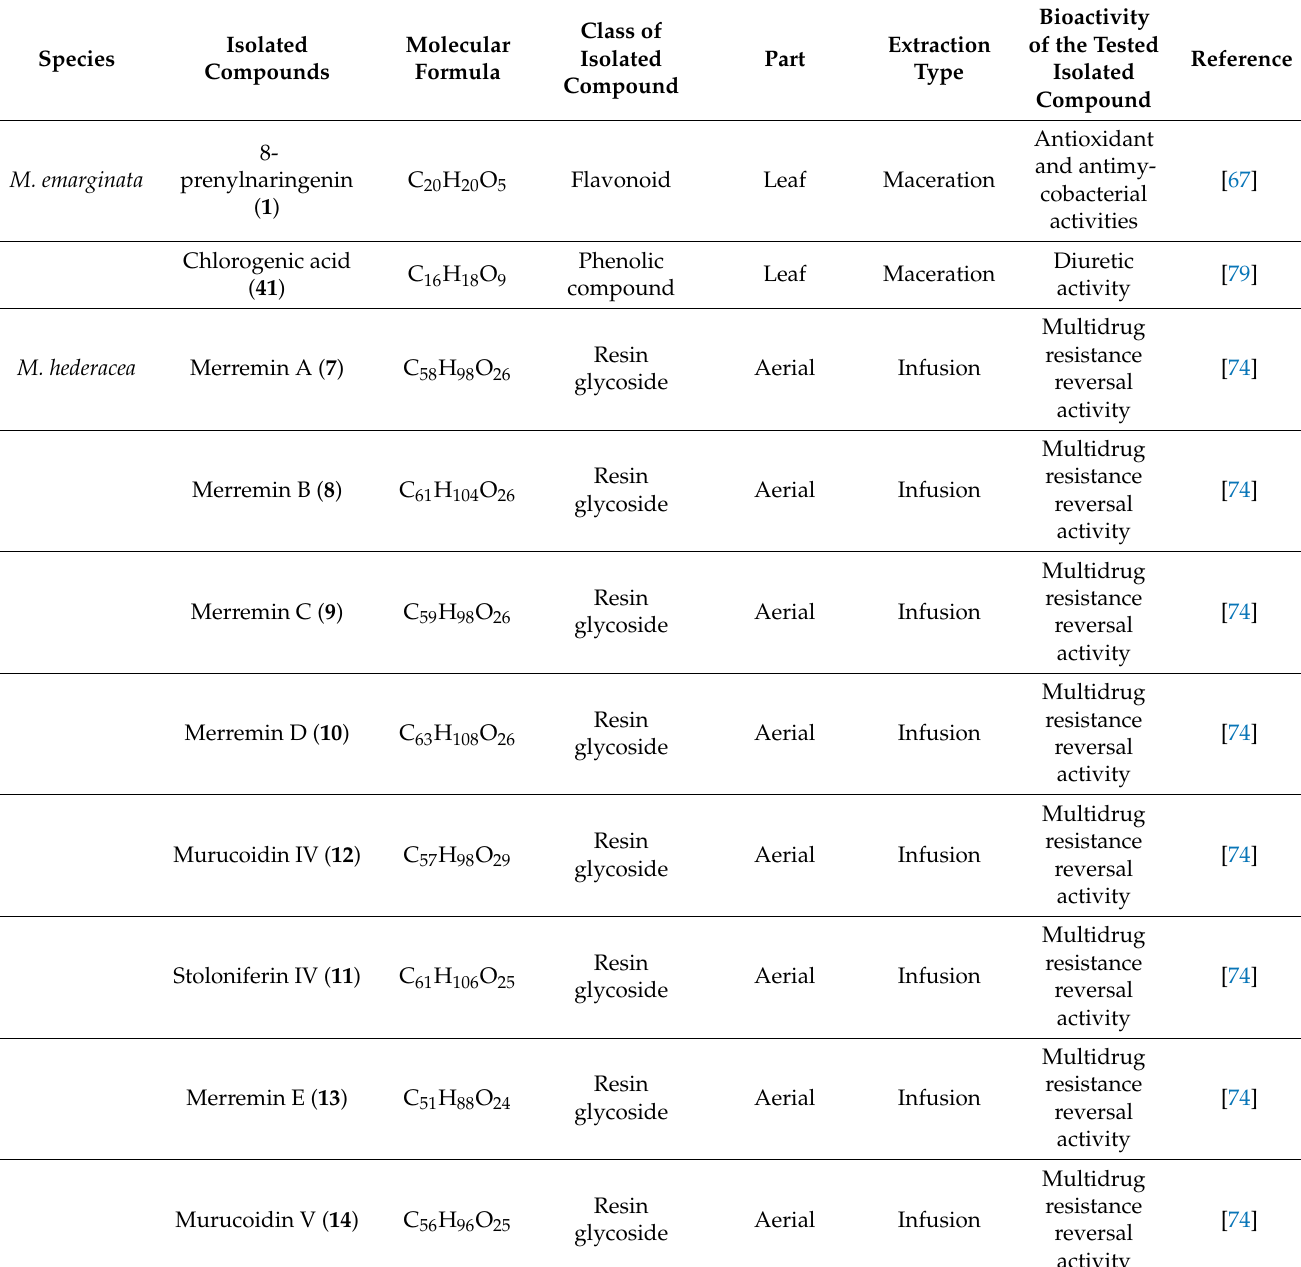
Table 5. Phytochemicals isolated from the genus Merremia